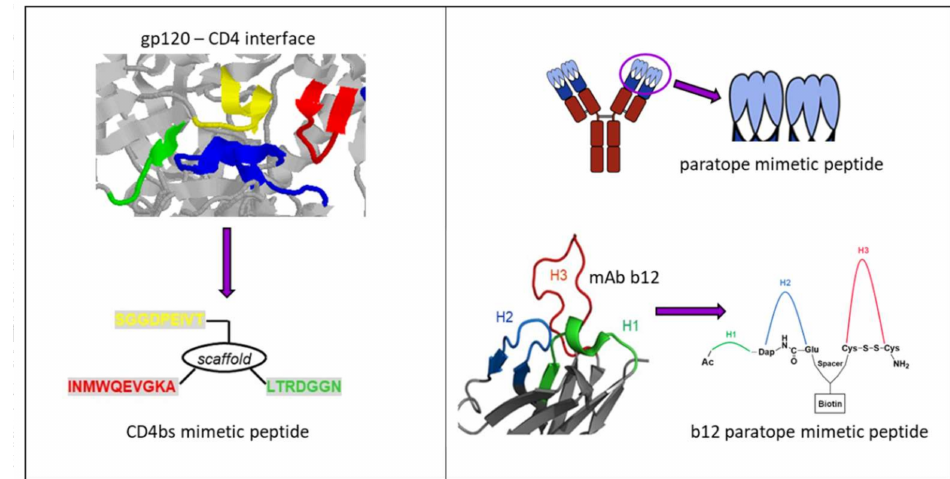
Figure 6. Peptides mimicking/targeting the complex CD4bs. ( Left ) Structure-based design of a CD4bs mimetic peptide (bottom) based on the crystal structure of a gp120-CD4 complex (top, pdb 1rzj). Fragments corresponding to the CD4bs are shown in red, yellow and green, respectively, and the CDR2-like loop of CD4 contacting gp120 is in blue. ( Right ) General design of antibody paratope mimetic peptides (top) and specifically for b12 (bottom) based on the b12-gp120 crystal structure (pdb